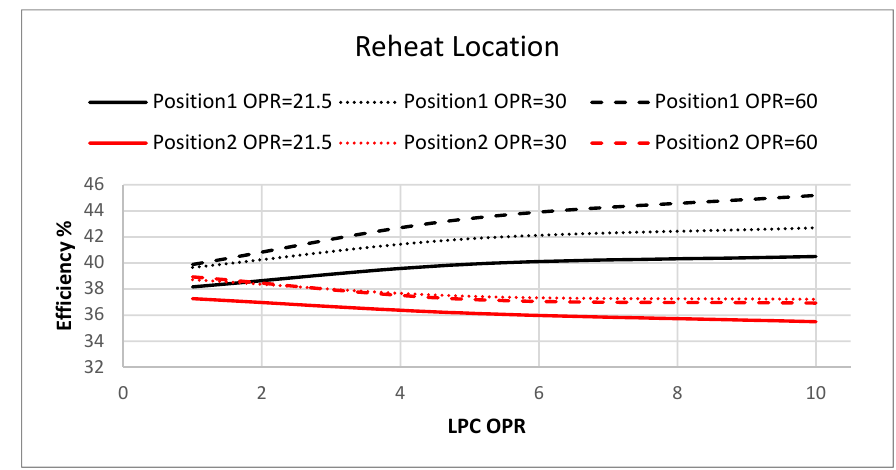
Figure 7. Effects of the compression ratio with different LPCs in the reheat cycle.